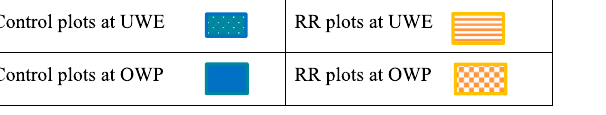
FIGURE7| Drymassofabovegroundplantmaterial(biomass)(gm − 2 )harvestedat (A) UWEand (B) OWP.Valuesaremean ± SE,n (cid:2) 6,12in2015.Note:atUWE plotswerecutinautumnandatOWPplotswerecutinearlyJulyandearlyOctober.Therewerenosheltersin2015atthetimeofbiomasssamplingsoallwereessentially Control plots.